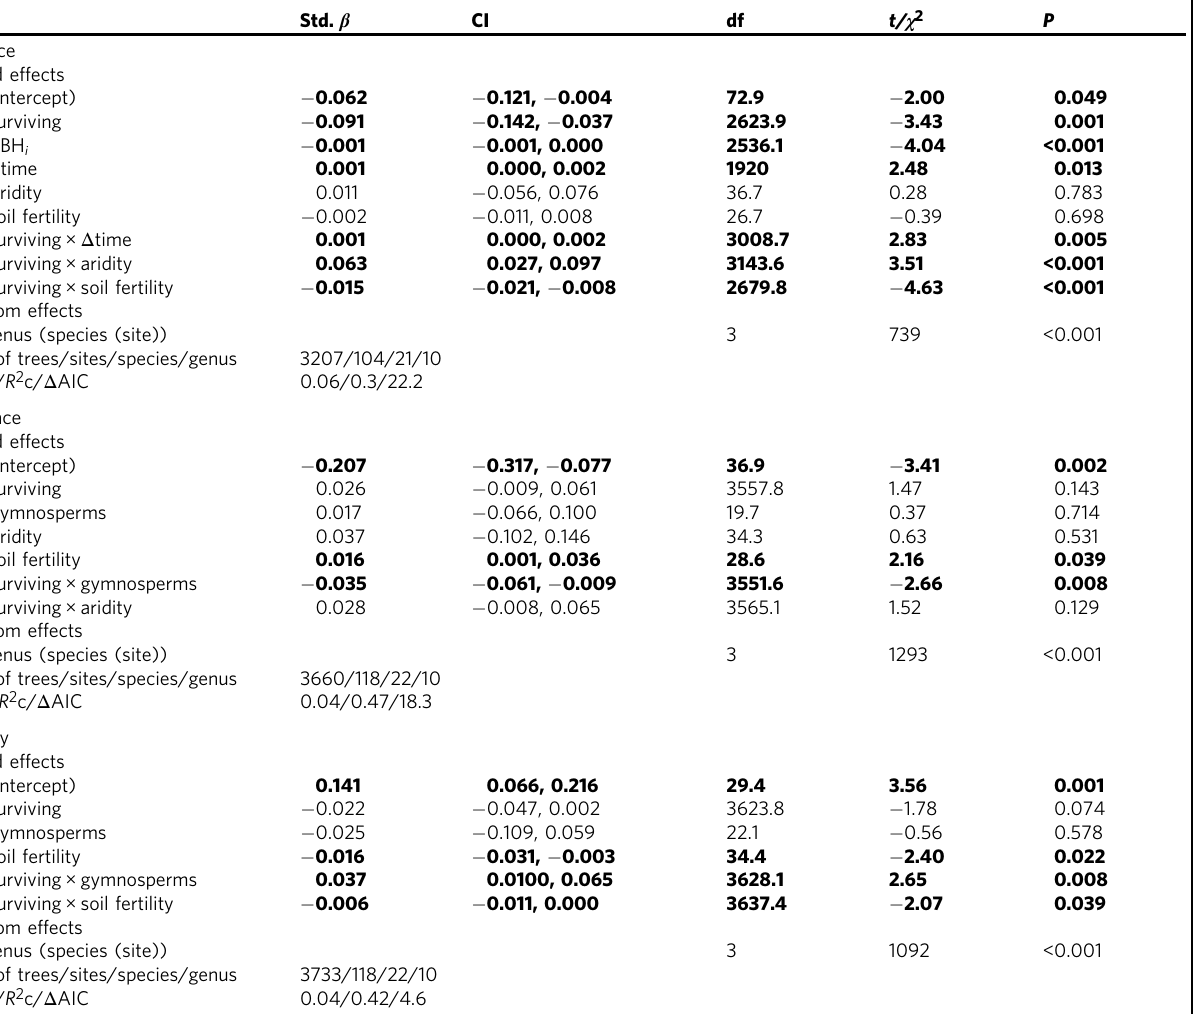
Table 1 Summary of the fi tted linear mixed model of resilience, resistance and recovery. Std.